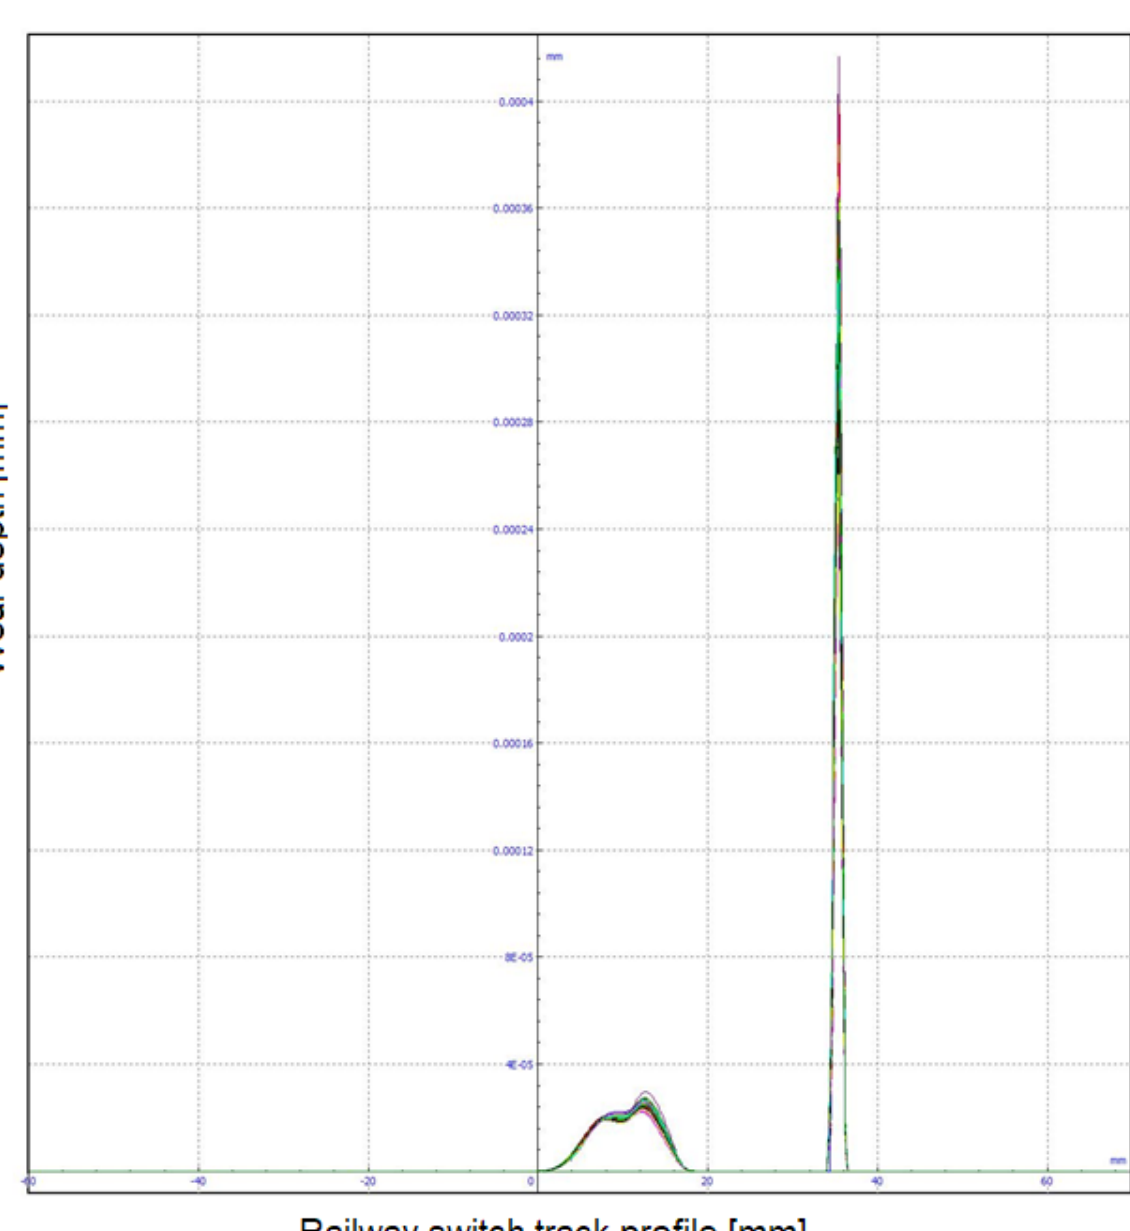
Figure 47. Wheel wear for a straight track without a turnout with constant stiffness obtained at 350 km/h.